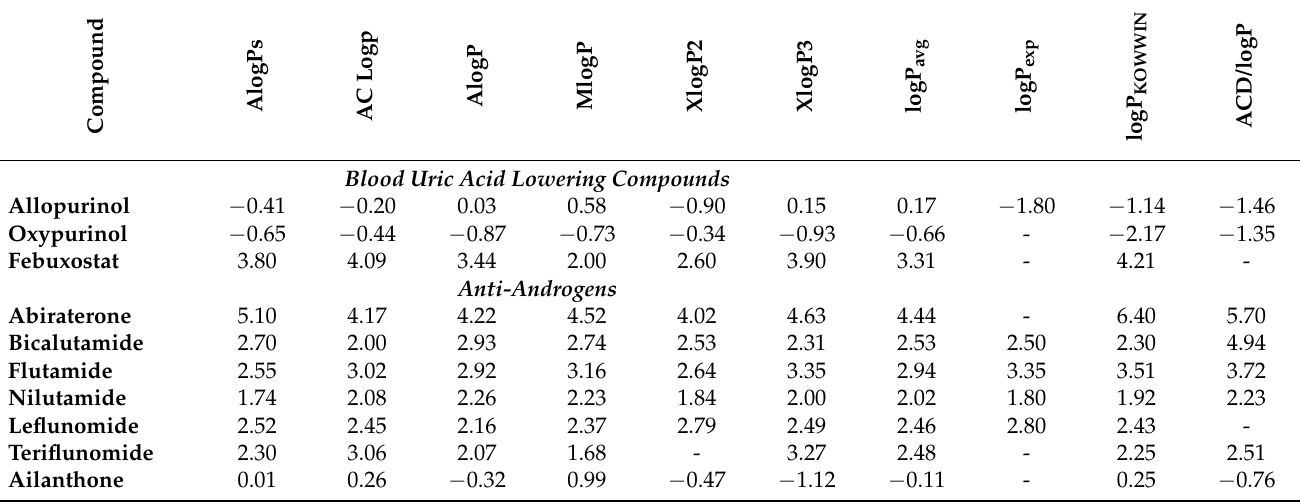
Table 1. Partition coefficients of studied compounds.